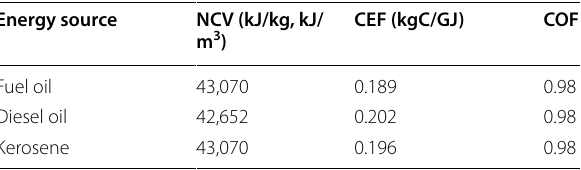
Table 2 Constant variables for computation of direct carbon